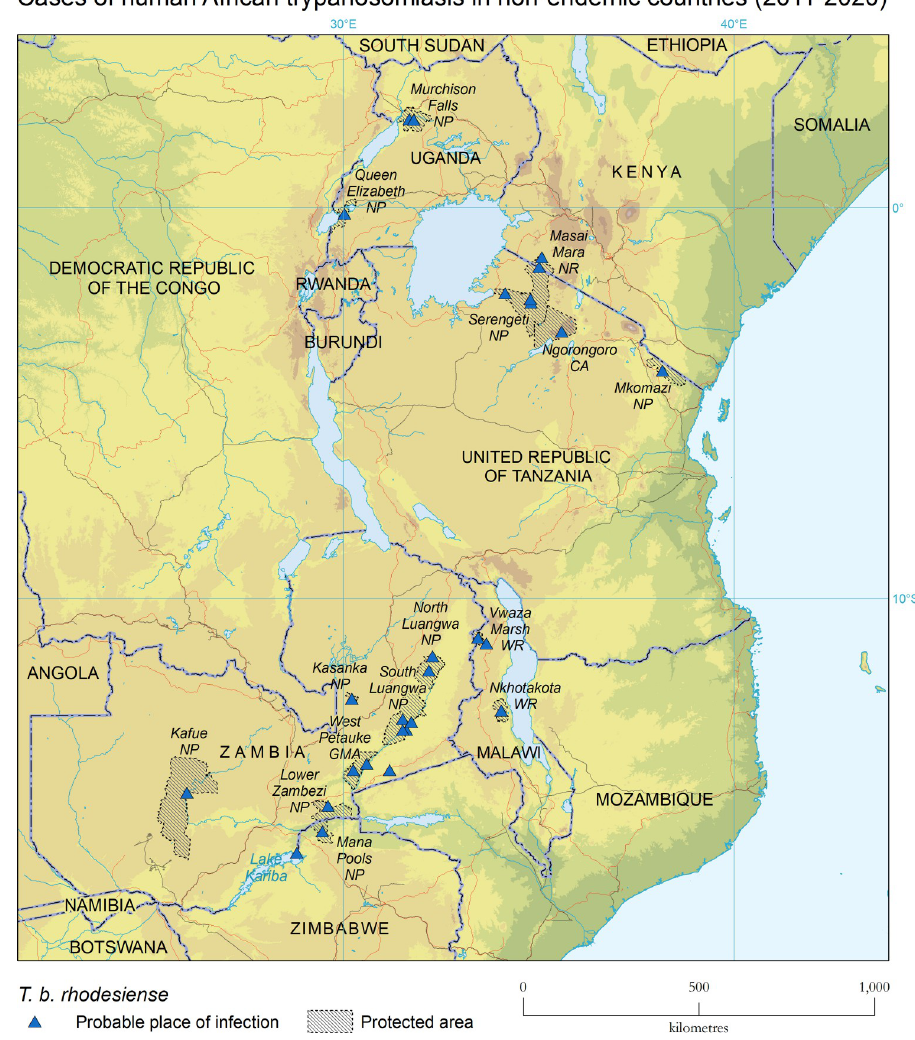
Fig 3. Probable place of infection of cases of rhodesiense HAT diagnosed in non-DEC. 2011–2020. The base layers used in this map are the FAO Global Administrative Unit Layers (GAUL)